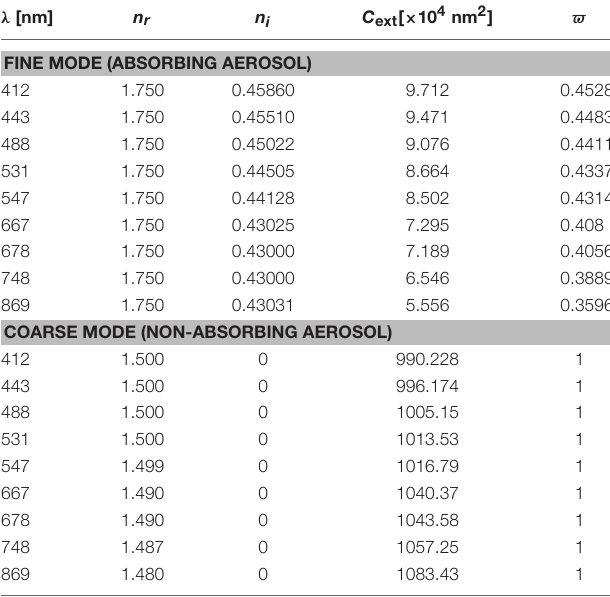
TABLE 1 | The aerosol complex refractive index at the 9 MODIS VIS channels used in this study is based on the SeaDAS model (Ahmad et al., 2010 and see also Figure 1 ), so that the spectral dependence of the complex refractive index is assumed to be true for a given relative humidity, in other words taken as a priori